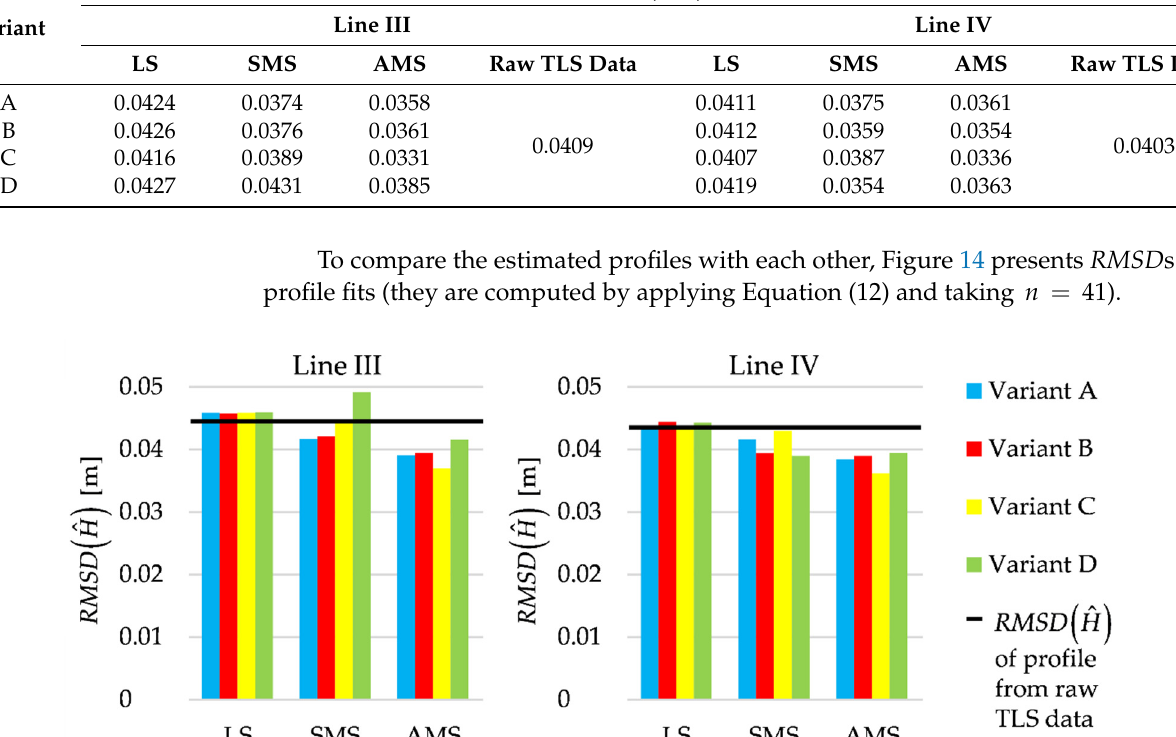
Table 3. Mean of